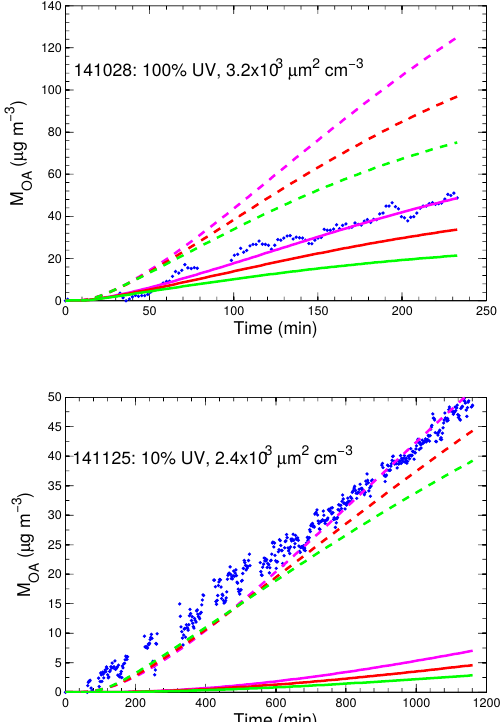
Figure 6. Mass of SOA as a function of time for one 100% UV and one 10% UV experiment. Experimental data are shown with filled circles. Lines show GECKO-A predictions when varying the branching ratio for the RO 2 + HO 2 reaction with differing vapor wall loss rates. Solid lines show predictions with k gw = 10 − 3 s − 1 , and dashed lines show predictions with k gw = 10 − 5 s − 1 . Pink lines show the base case predictions, in which the branching between formation of the hydroperoxide and the alkoxy from RO 2 + HO 2 is 80:20. For the red lines, the branching ratio is 50:50; for the green, it is